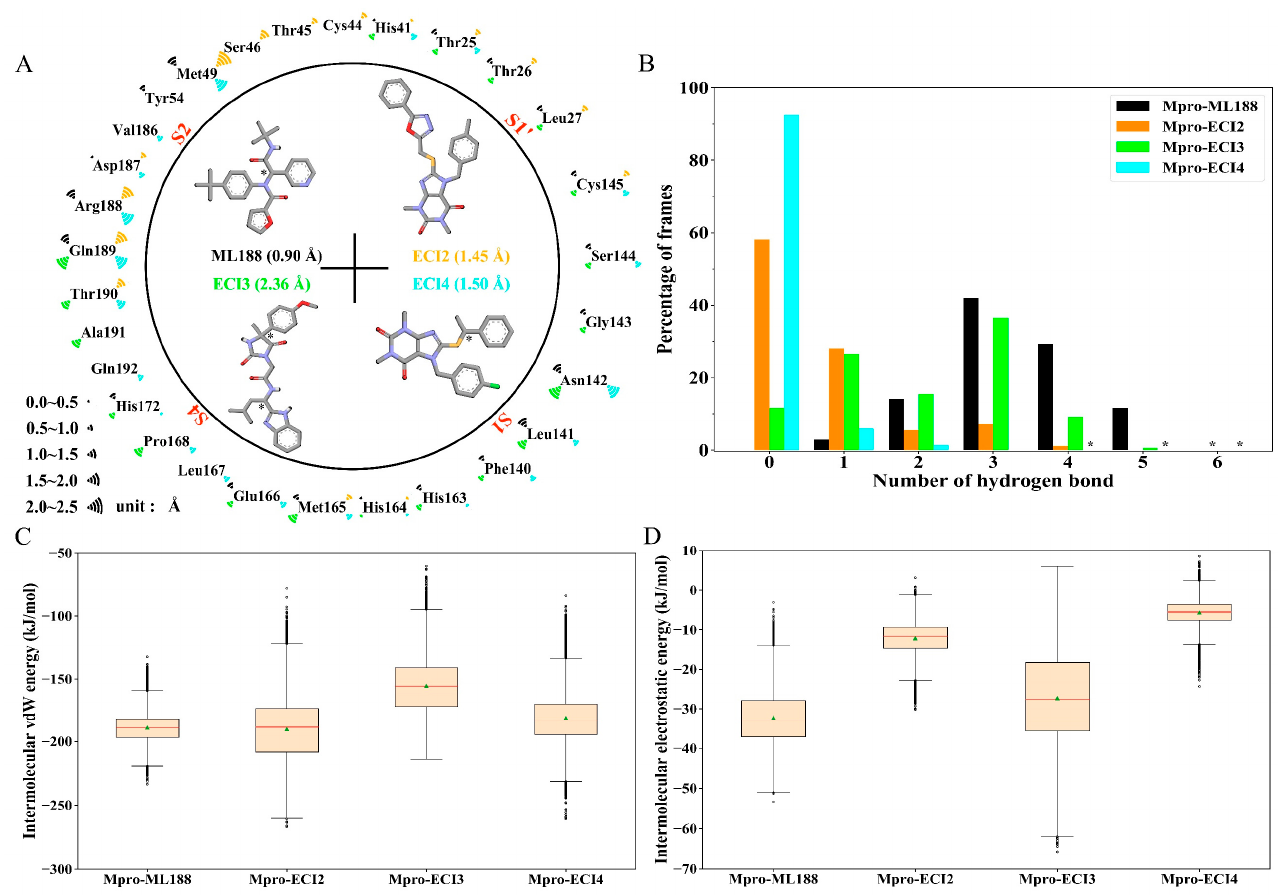
Figure 5. Interface residues and inter-molecular interaction statistics of Mpro-ML188 and Mpro-ECI2-4 during the equilibration simulations. ( A ) Identified Mpro interface residues for the four inhibitors. Skeletal formulas of ML188 and ECI2-4, along with their full-atom root mean square fluctuation (RMSF) values (in parentheses), are shown within the circle. The chiral centers in these molecules are indicated by an asterisk. The magnitudes of the all-atom RMSF values of the Mpro interface residues are marked using the Wifi-like signal strength icon with different colors. ( B ) Histogram showing the distributions of the inter-molecular hydrogen bond (HB) number. ( C ) Boxplot showing the inter-molecular van der Waals (vdW) interaction energy distributions. ( D ) Boxplot showing the inter-molecular electrostatic interaction energy distributions.